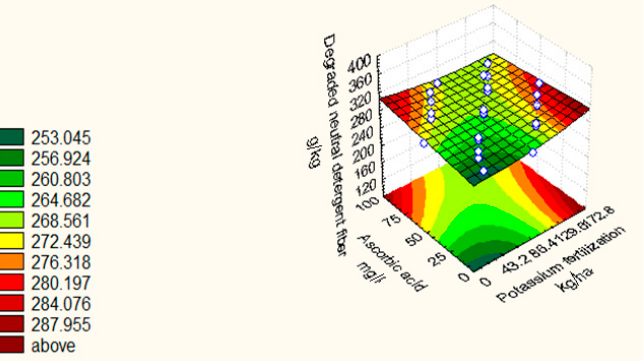
Figure 5. Response surface for neutral detergent fiber ( a ), acid detergent lignin ( b ) and degraded neutral detergent fiber ( c ) as affected by AA and HA at the central levels of PF and AC in 2018/19.